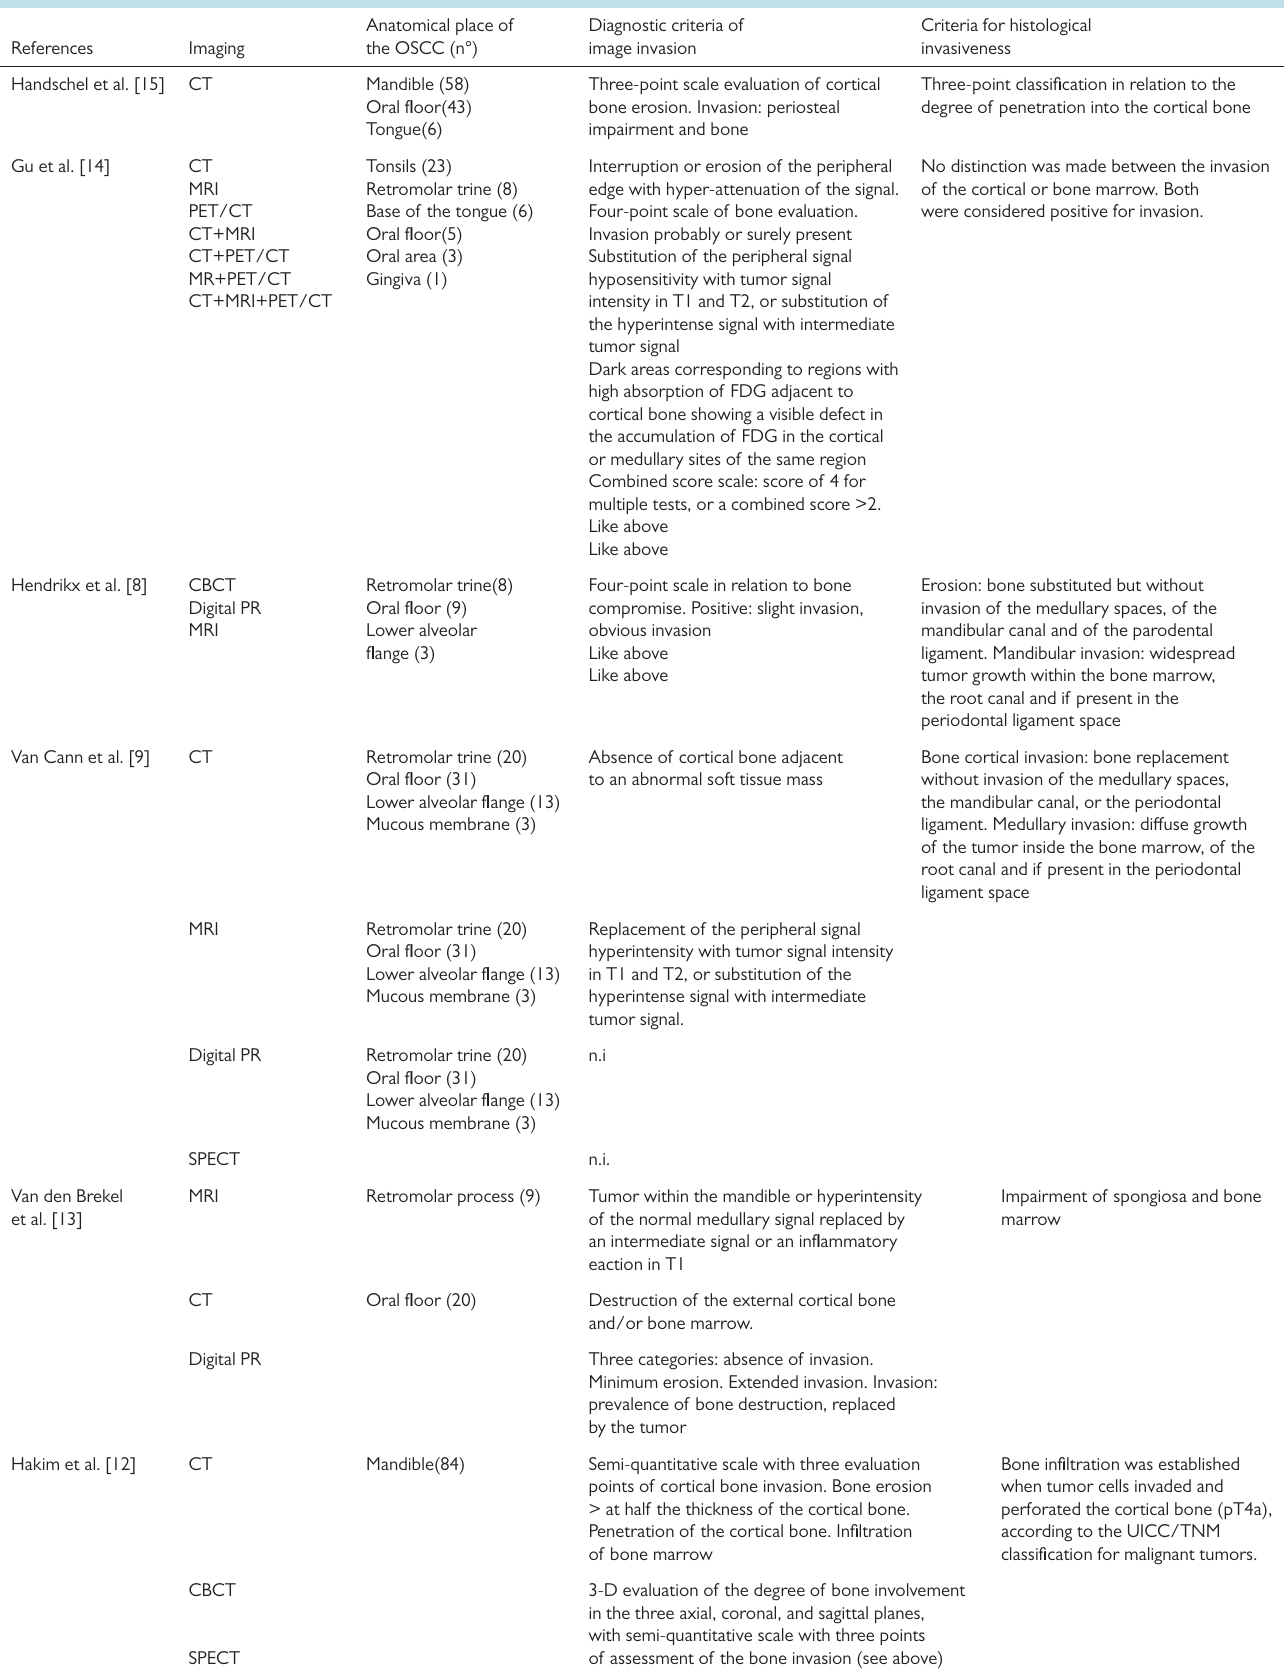
Table 3. Types of diagnostic imaging methods, site of the tumors, and invasiveness criteria for the imaging and histopathological